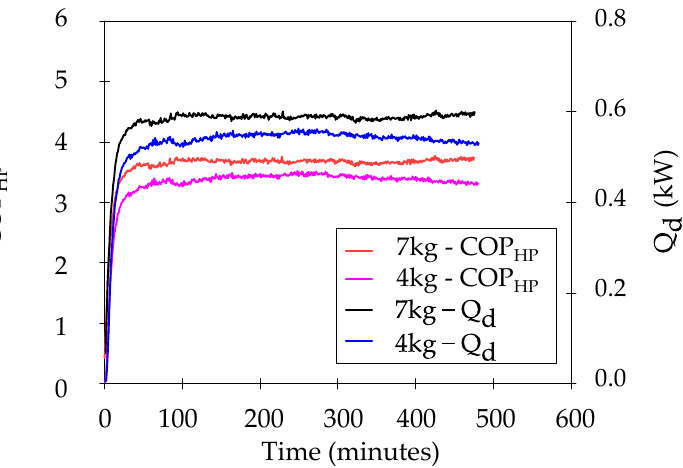
Figure 18. Variation in COP HP and the sensible heat transfer rate at the condenser for the modified drying chamber.